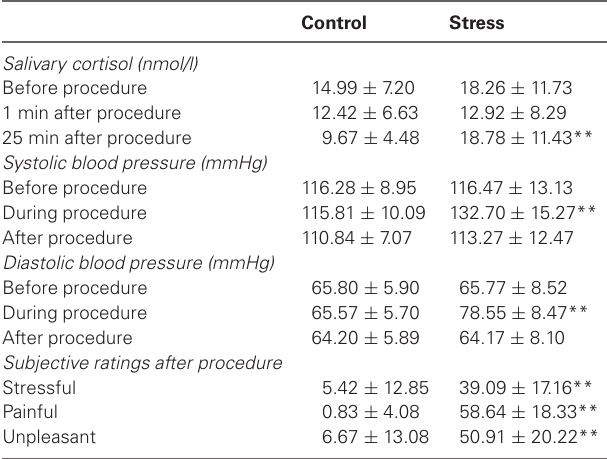
Table 2 | Salivary cortisol concentrations and blood pressure responses to as well as subjective ratings of the SECPT vs. control procedure.